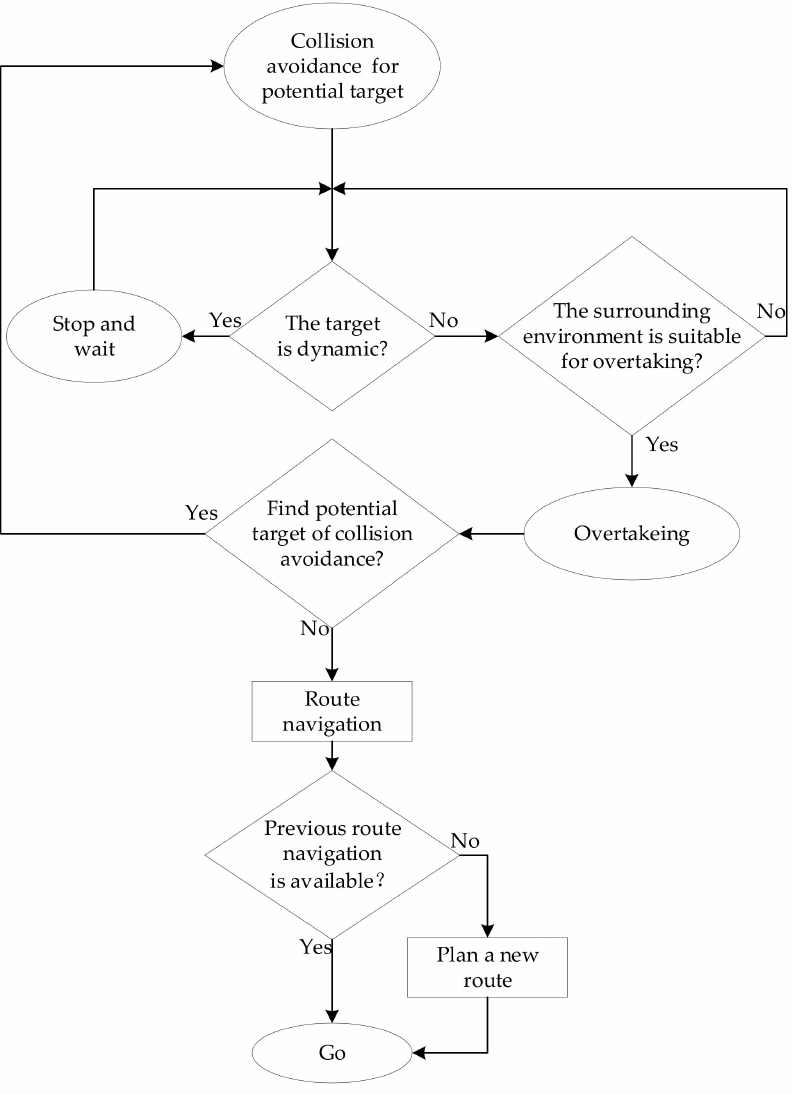
Figure 5. The flow chart of collision avoidance and